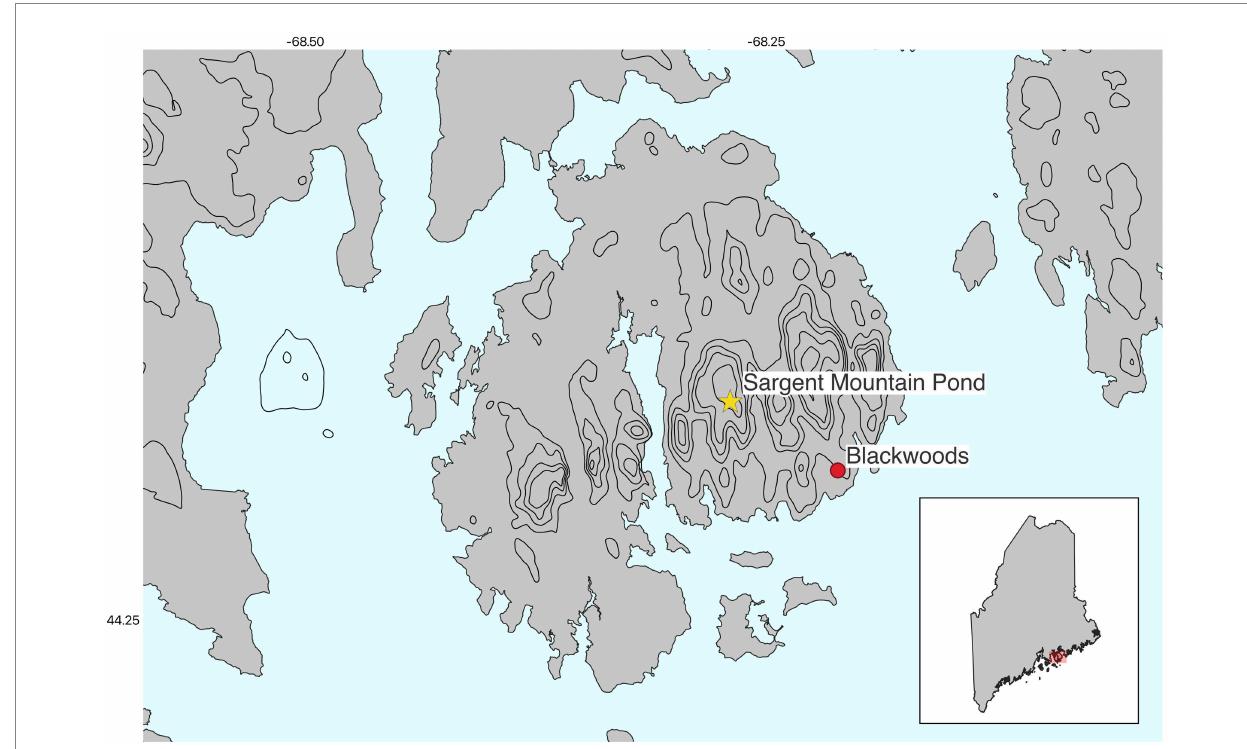
FIGURE 2 Location of the two cores from Mount Desert Island relative to the state of Maine. The star depicts our core, and the red dot depicts a forest hollow core collected at the Blackwoods campground (Schauffler and Jacobson, 2002).